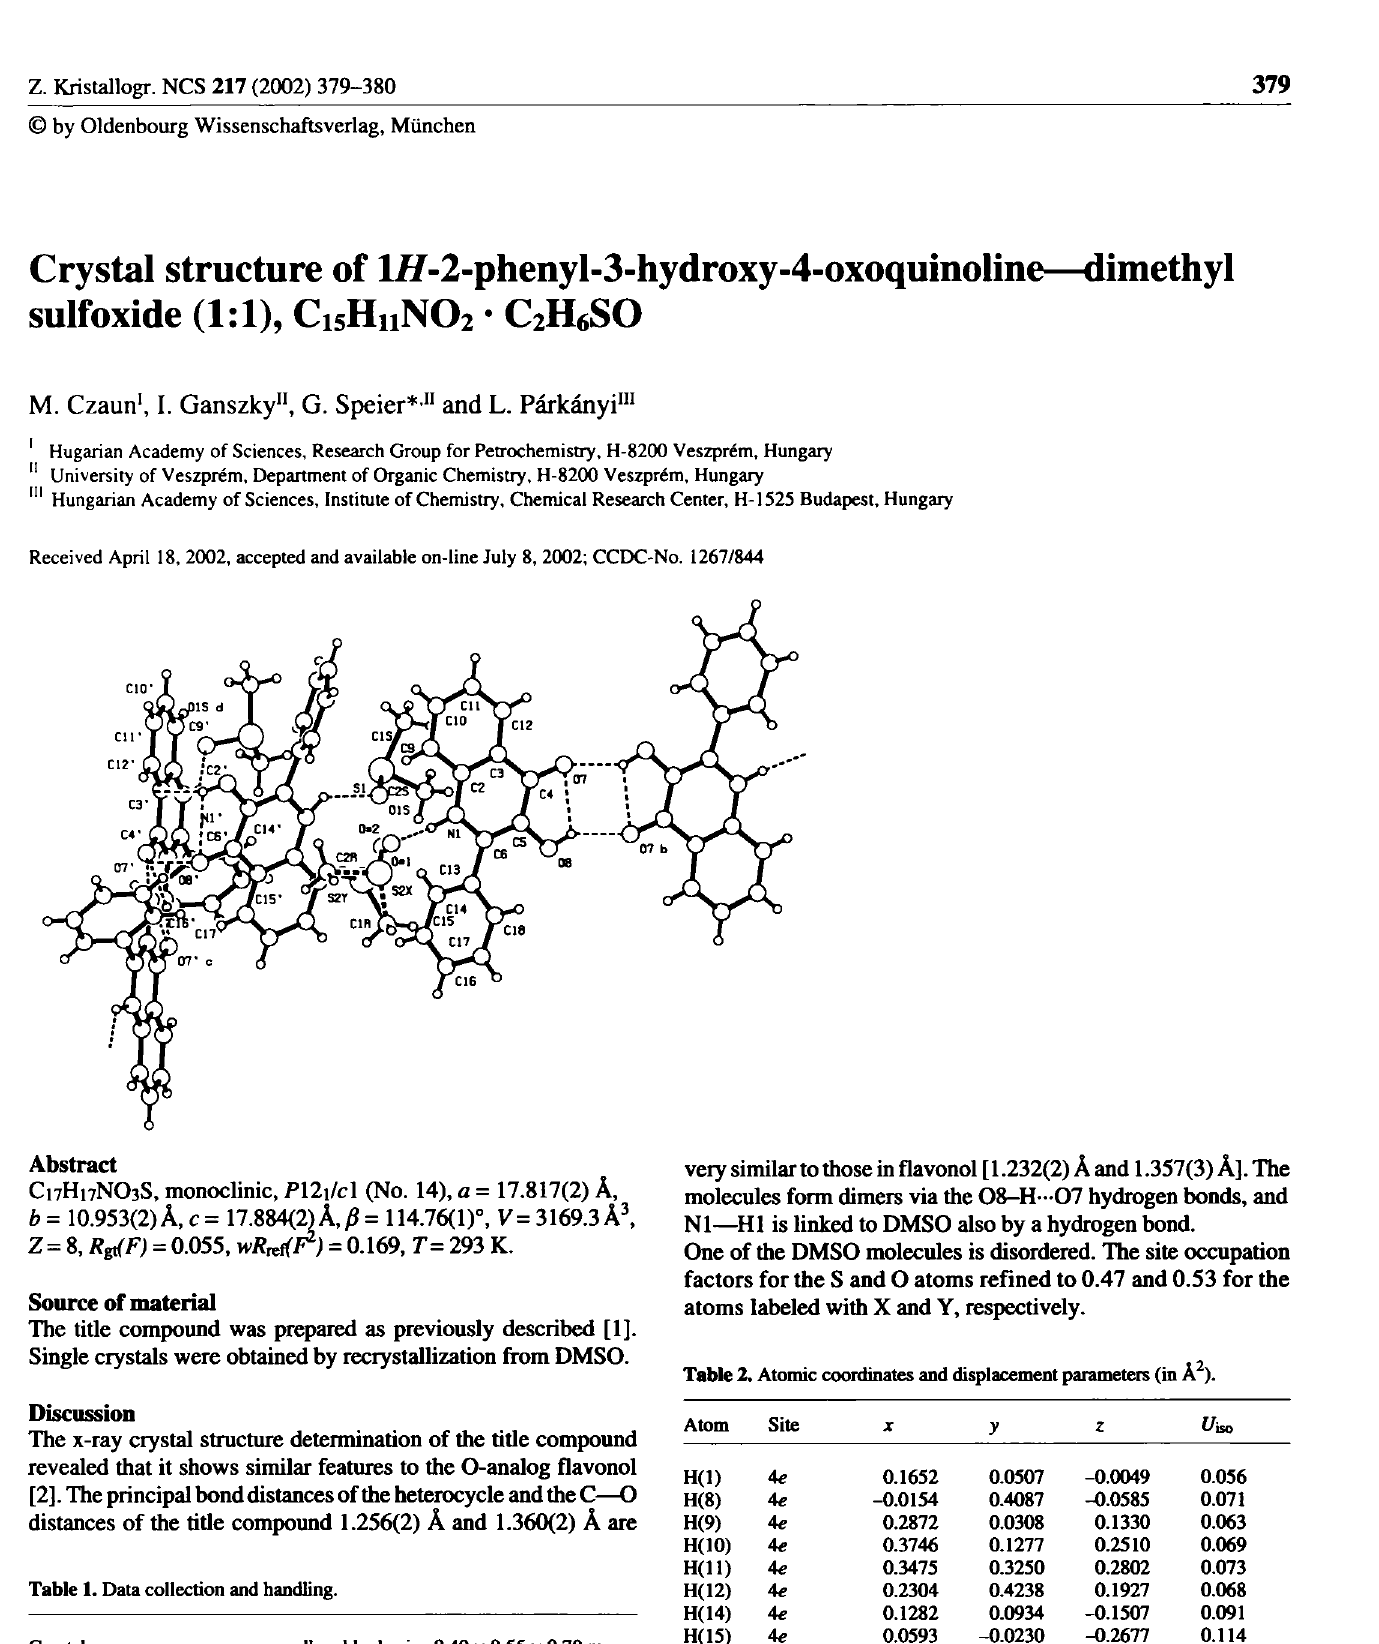
Table 1. Data collection and handling.